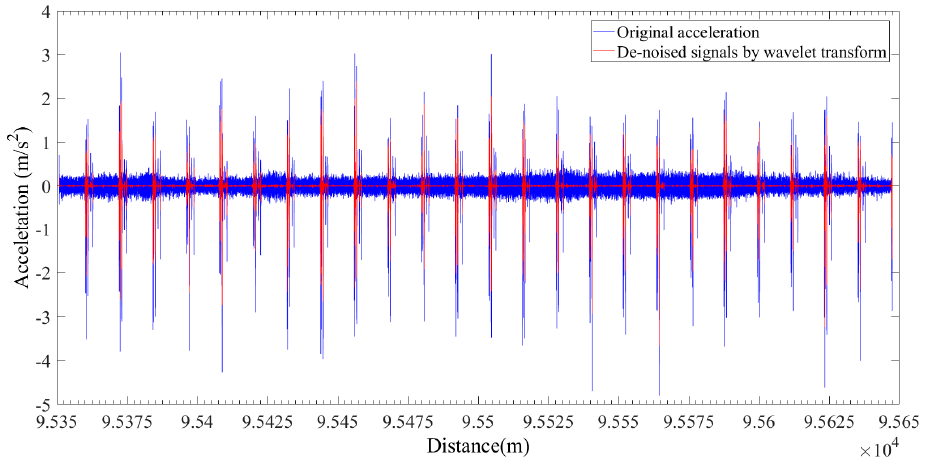
Figure 9. Comparison between original signals of inertial measurement acceleration and de-noised signals through wavelet transform.